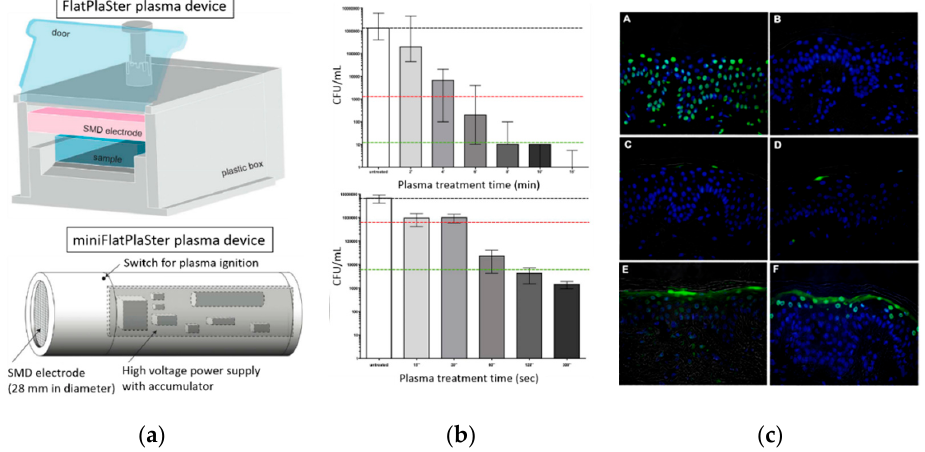
Figure 13. ( a ) Two plasma devices used by Maisch et al. for decolonization of microorganisms on large skin areas, ( b ) decolonization of S. aureus using the two devices and ( c ) histological evaluation of ex vivo porcine skin after plasma treatment: ( A ) positive control, ( B ) negative control, ( C ) immediately after 15 min treatment, ( D ) 24 h after 15 min treatment, ( E ) 48 h after 15 min treatment and ( F ) 48 h of an untreated skin sample. Reprinted from [223].